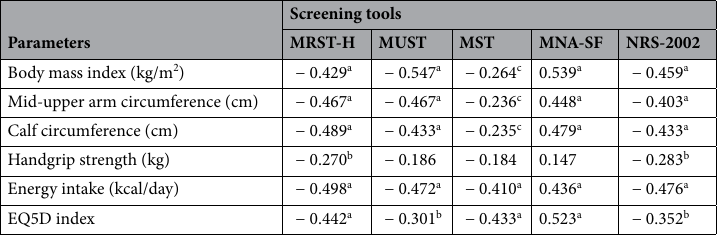
Table 8. Correlations of different malnutrition screening tools with anthropometric, dietary and health- related quality of life in elderly group. a P < 0.001; b P < 0.01; c P < 0.05; Spearman’s rank correlation coefficient.